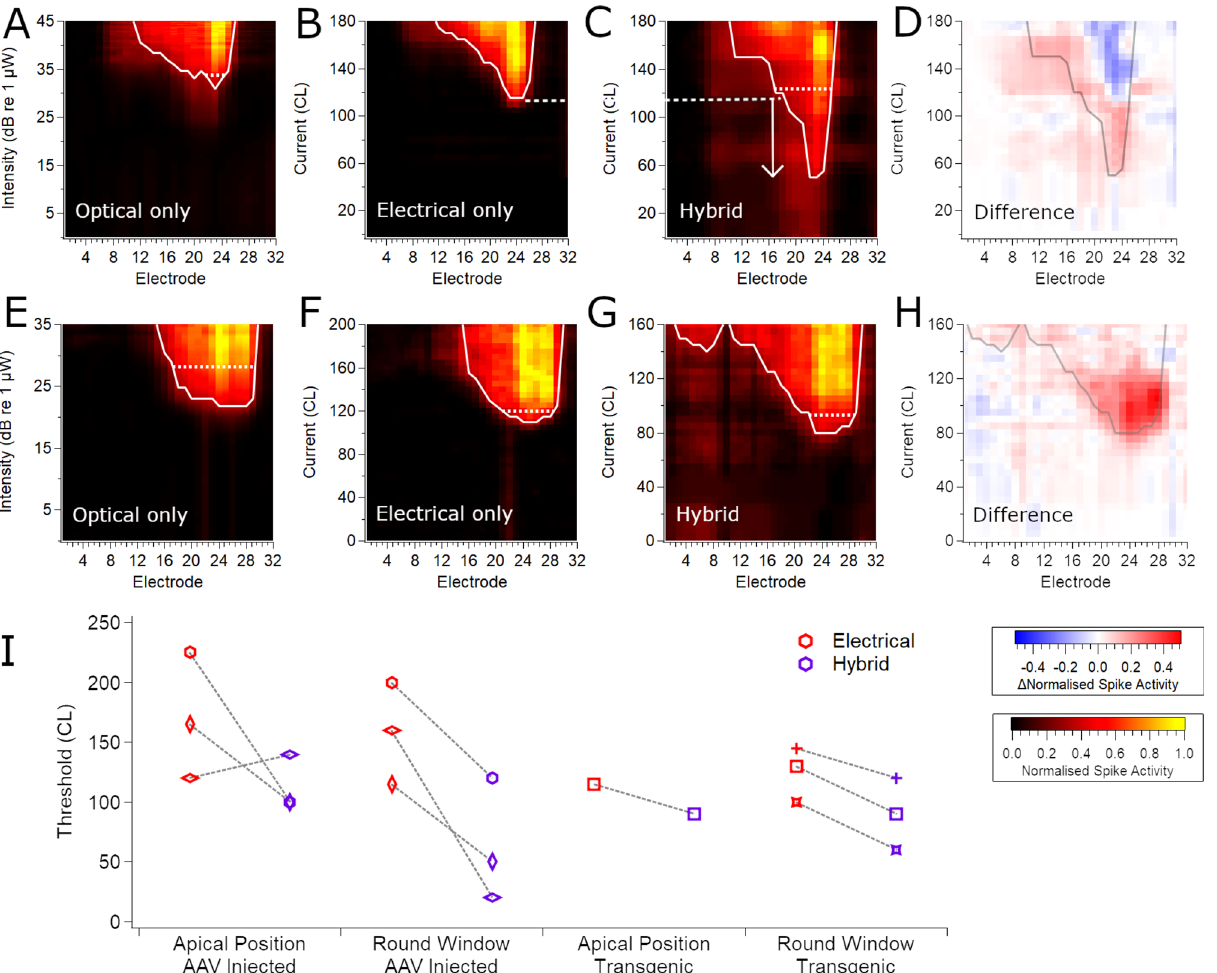
Figure 8. Interaction between electrical and optical stimuli reduces electrical thresholds. Example response images from a C57BL/6 neonatally AAV-injected mouse ( A-D ; up to 82% ChR2-H134R-EYFP transduced cells in the basal-mid turn region) or a ChR2-H134R-EYFP transgenic mouse ( E–H ) showing the spatial extent and rate of multi-unit activity across the recording array in response to RWM-applied 1 ms optical pulses ( A, E ), 100 µs/phase electrical pulses ( B, F ) or hybrid stimulation for which the electrical pulse was delayed by 1.75 ms relative to the optical pulse which was sub-threshold (63% of threshold optical power) ( C, G ). The dashed line/ arrow between B and C shows the reduction in threshold afforded by the subthreshold optical stimulus applied prior to the electrical stimulation. ( D, H ) Difference plots to highlight activity that was greater or lower than the sum of the individual optical and electrical recordings in A-B or E–F. Response images were generated as per Fig. 4. The dotted lines on each spatial tuning curve compare the width of activation at an equivalent level above threshold (d’ = 1 above threshold). ( I ) Electrical thresholds for electrical stimulation alone (red) or when a subthreshold optical pulse was applied 1.75 ms prior to the electrical pulse (hybrid stimuli; purple) in the apex and RWM of the cochlea (n = 3 for injected mice and n = 1–3 for transgenic mice; a dashed line links data from the same mouse; individual mice are symbol-coded). Individual mice are symbol-coded. Basal turn data from ChR2-H134R-EYFP mice are a subset of the data presented in 35